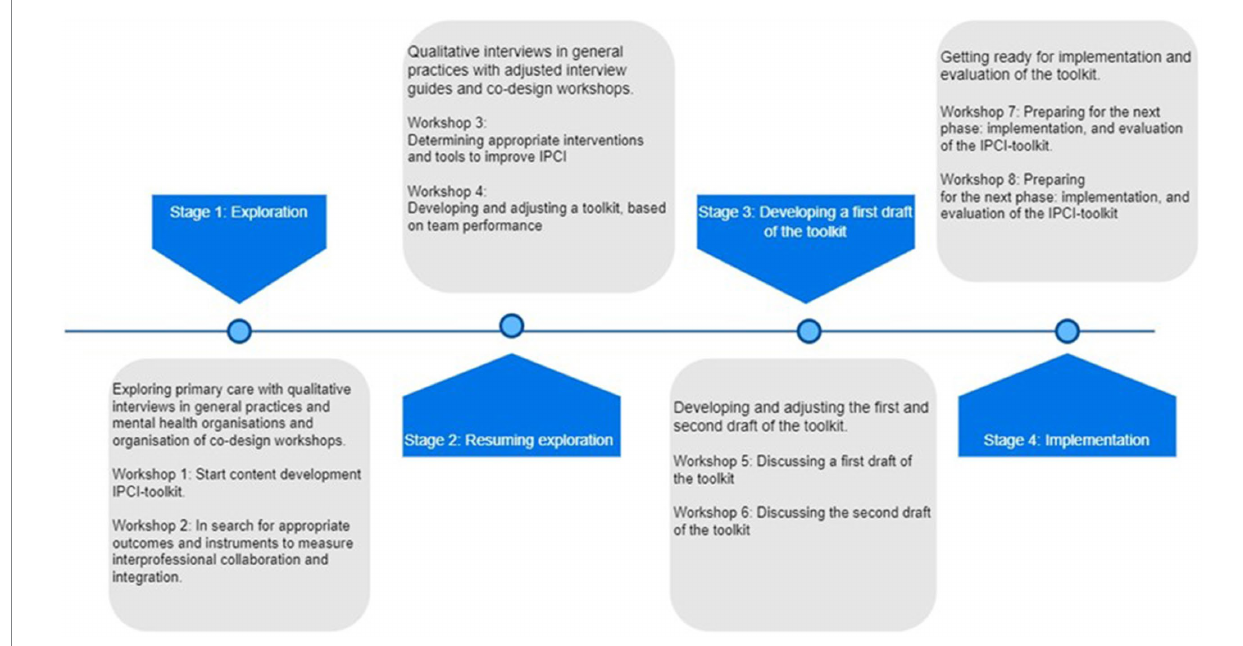
FIGURE 1 An overview of the two-year development process of the IPCI-toolkit* existing of four stages: exploration, resuming exploration, developing a first draft of the toolkit, and implementation. *IPCI, Interprofessional collaboration and integration in primary